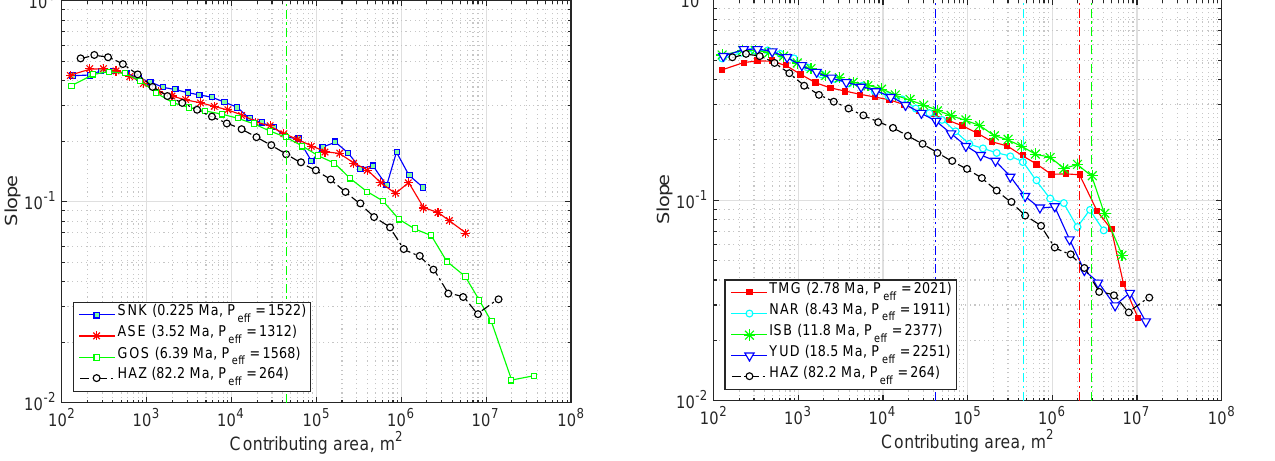
Figure 10. Mean slope–area relationship for the catchments with tectonic uplift of 250m in the Quaternary. Vertical dashed lines rep- resent visually determined larger inflection point for GOS (4 . 4 × 10 4 m 2 ).